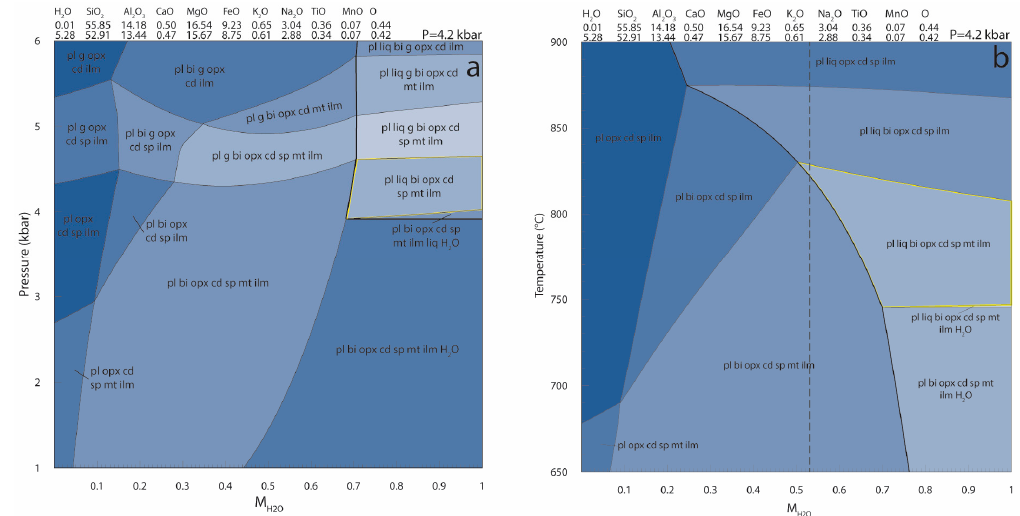
Figure A2. ( a ) P–M H2O model calculated to constrain the H 2 O content of sample 14-RDC-04. The bold line represents the solidus. The field outlined in yellow represents the peak assemblage observed in the sample. ( b ) T–M H2O model calculated to constrain the H 2 O content of sample 14-RDC-04. The bold line represents the solidus. The field outlined in yellow represents the peak assemblage observed in the sample. The dashed line is the composition on the x-axis that was chosen for further